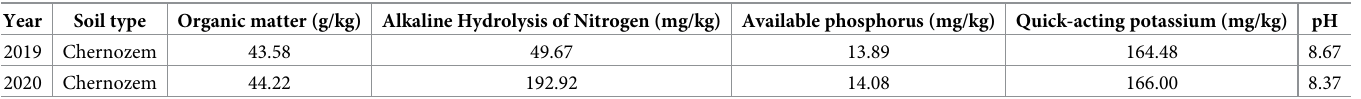
Table 1. Soil nutrient content selected in the